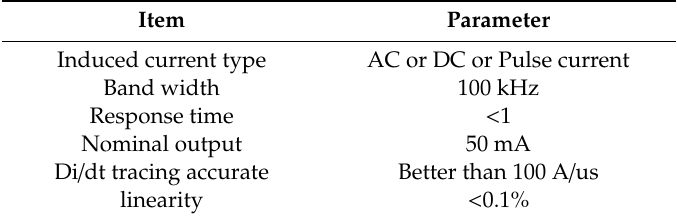
Table 1. The main performance parameters of the closed-loop Hall current sensor.